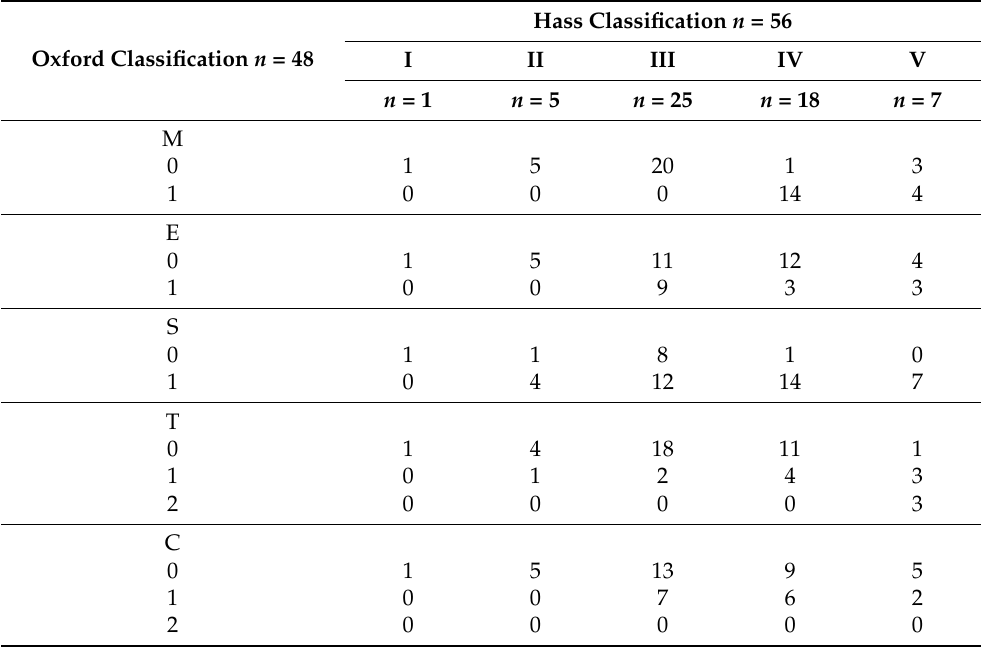
Table 3. Combined Hass and Oxford classifications of IgAN. Number of patients ( n